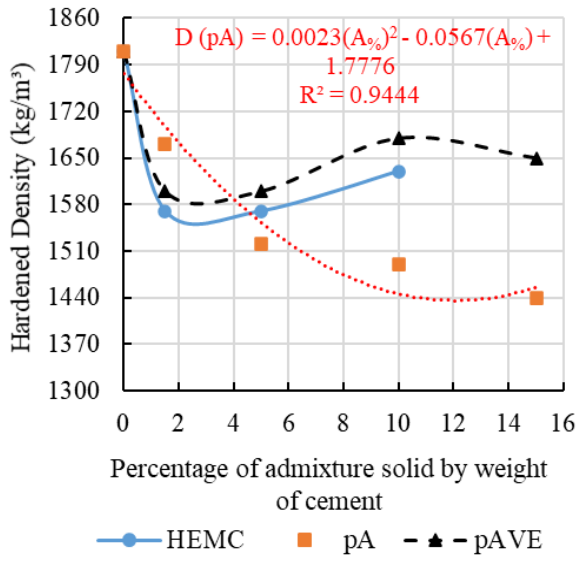
Figure 8. Hardened Density